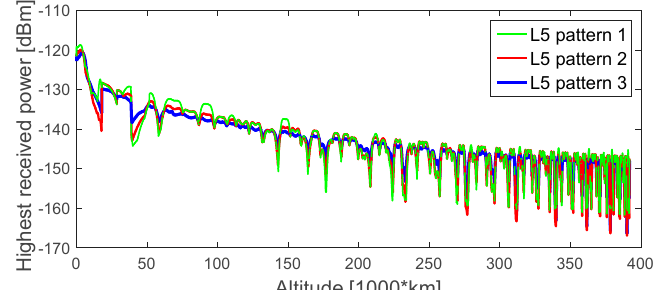
Figure 19. Highest received power level of GPS L5 signals, during the considered MTO, for a 0 dBi receiver gain pattern.